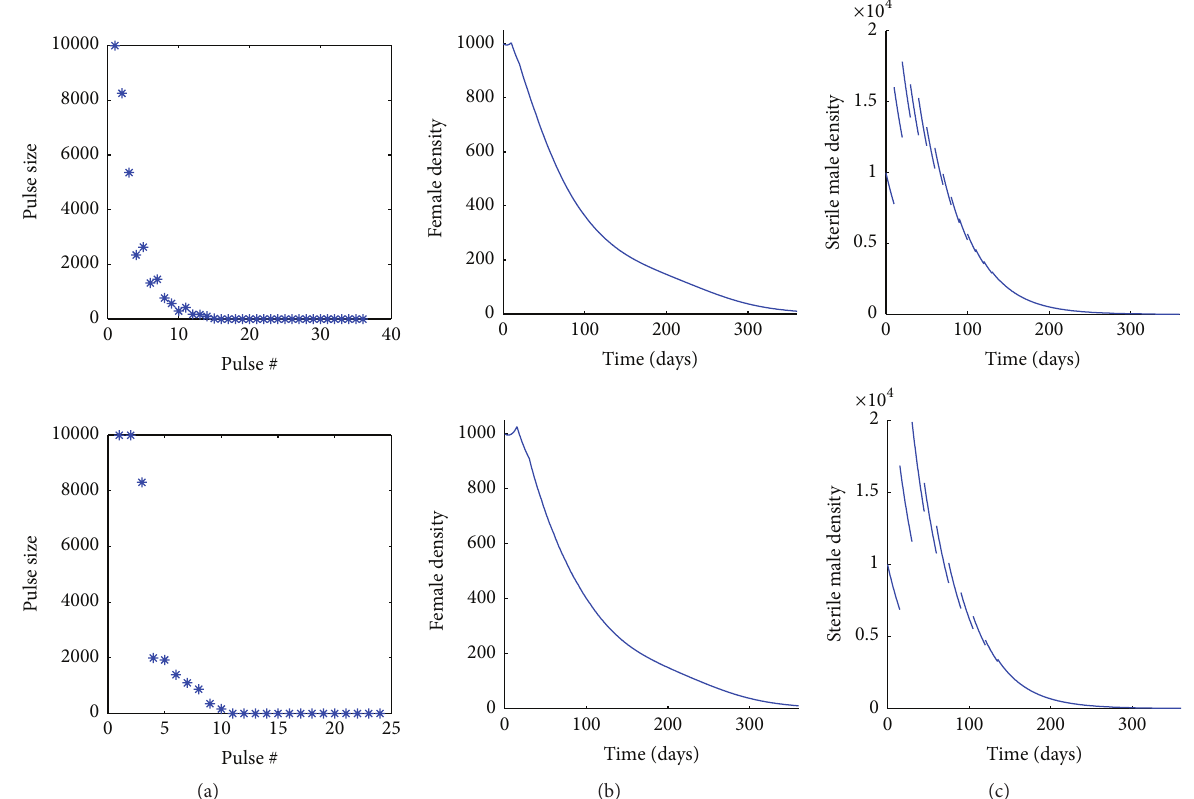
Figure 2: (a) Approximations to optimal sterile male pulse sizes obtained assuming that the maximum release of insects is limited to ten times the initial density (taken equal to 1000). ((b) and (c)) Progress of female and sterile male densities, with pulses of sterile males made every ten days (top) and fifteen days (bottom). Notice that (i) the maximum release is required only at the beginning stages, until the sterile population overflows the wild population and (ii) release of sterile males is not required after the Allee effect takes place and drives the remaining pest population to